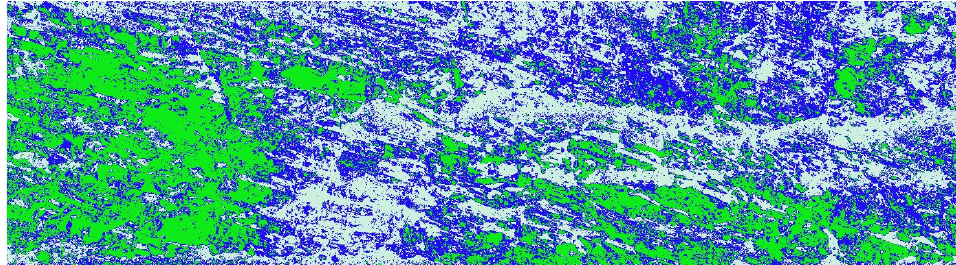
Figure 11. Coloured cluster map of the Pick Pit orthomosaic using ISO Cluster Classification Tool for three classes.